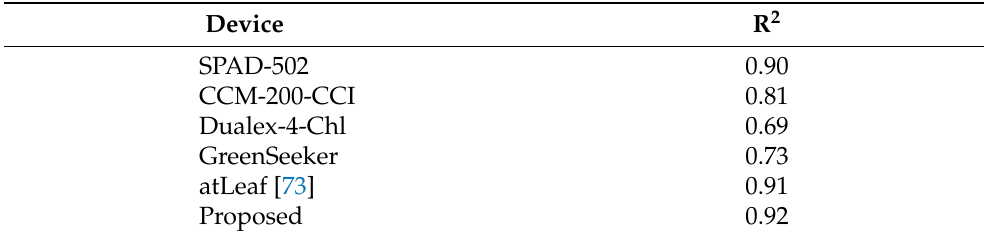
Performance comparison of handheld chlorophyll meters and the proposed vision- based